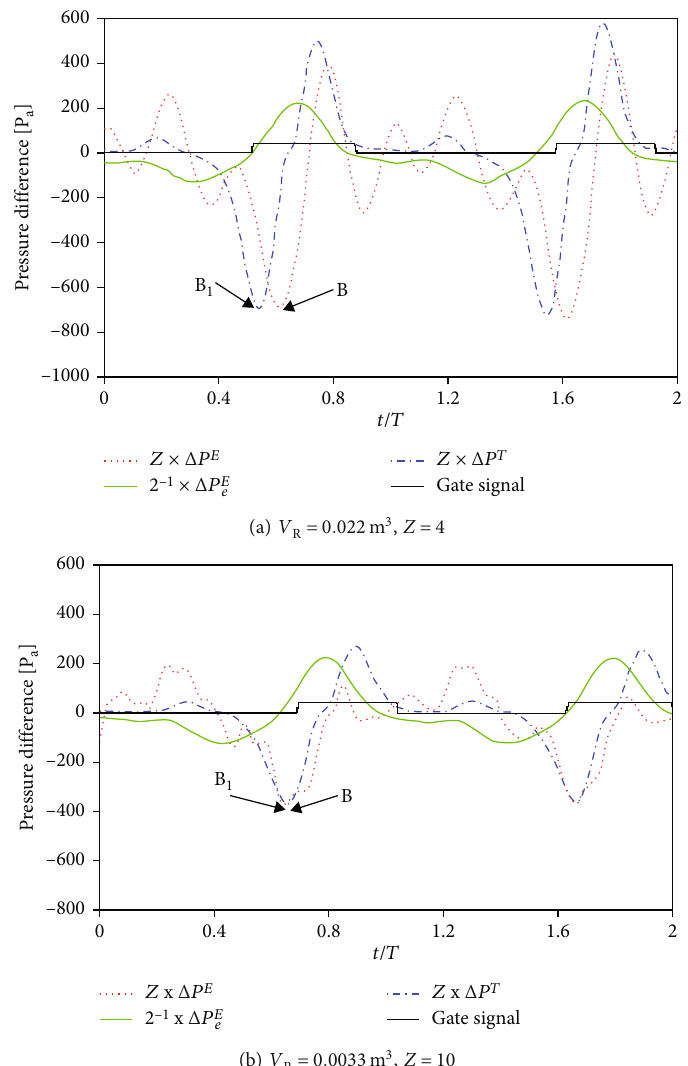
Figure 6: Same as Figure 4 but Z = 10 ; T is the period of a cycle; fi tting the negative side pressure jumps with a negative pressure loss coe ffi cient, ξ = ξ min